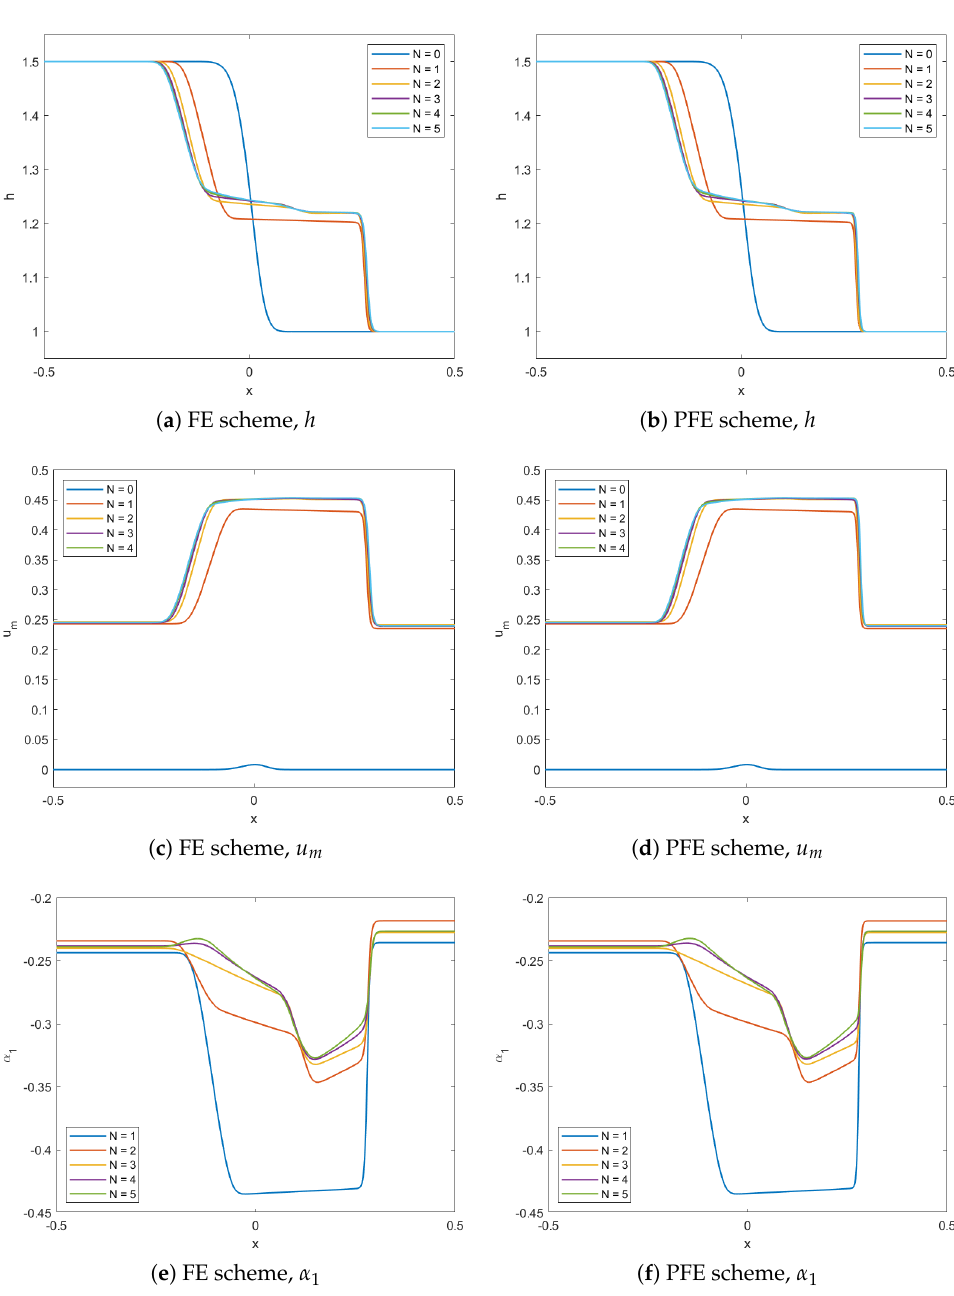
Figure 13. Dam break test case using FE ( a , c , e ) and PFE ( b , d , f ) schemes, for height h ( a , b ), mean velocity u m ( c , d ), and first moment α 1 ( e , f ), for varying N and constant ν = 0.1 and λ = 10 − 4 shows visibly the same accuracy for the PFE